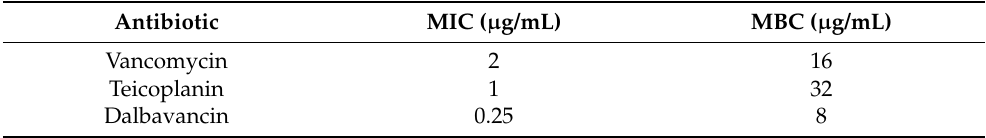
Table 1. Minimum inhibitory concentration (MIC) and minimum bactericidal concentration (MBC) of vancomycin, teicoplanin, and dalbavancin towards S. epidermidis . Values represent the average of data from three independent